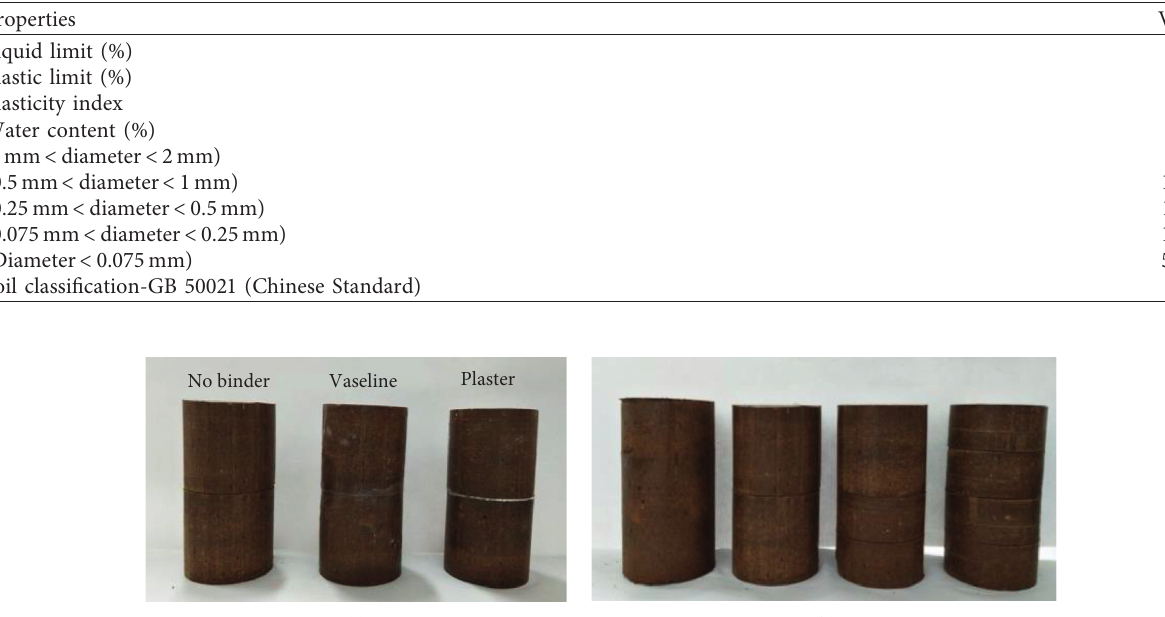
Table 1: The basis physical parameters of disturbed soil.